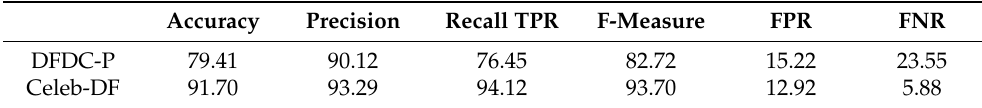
Table 9. Video-level results (%) calculated from the provided performance